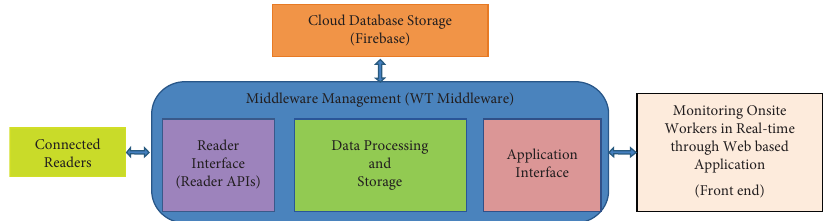
Figure 19: WTMiddleware management interface.